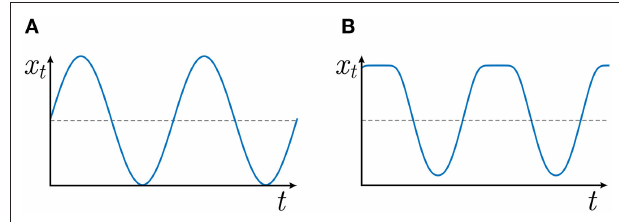
FIGURE 2 | Examples of harmonic (A) and non-harmonic (B) periodic pattern.